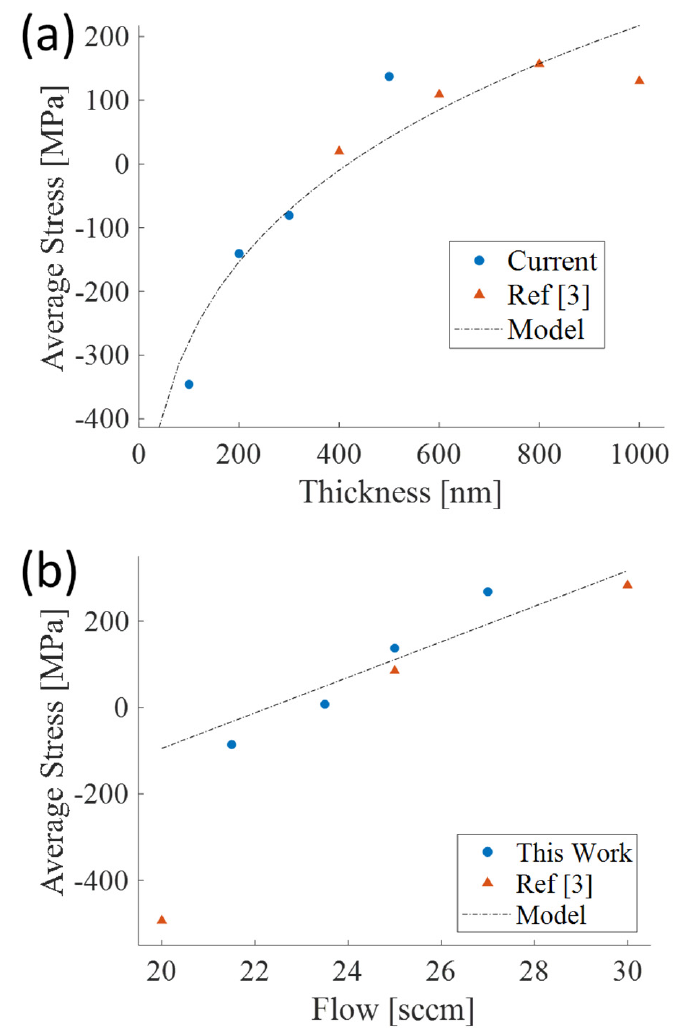
Figure 2. Average stress plots of PVD deposited Al 0.68 Sc 0.32 N films with ( a ) Average stress versus thickness plot at a constant 25 sccm N 2 flow and ( b ) Average stress versus flow for 500 nm Al 0.68 Sc 0.32 N with pure N 2 flow from 20–30 sccm [3].